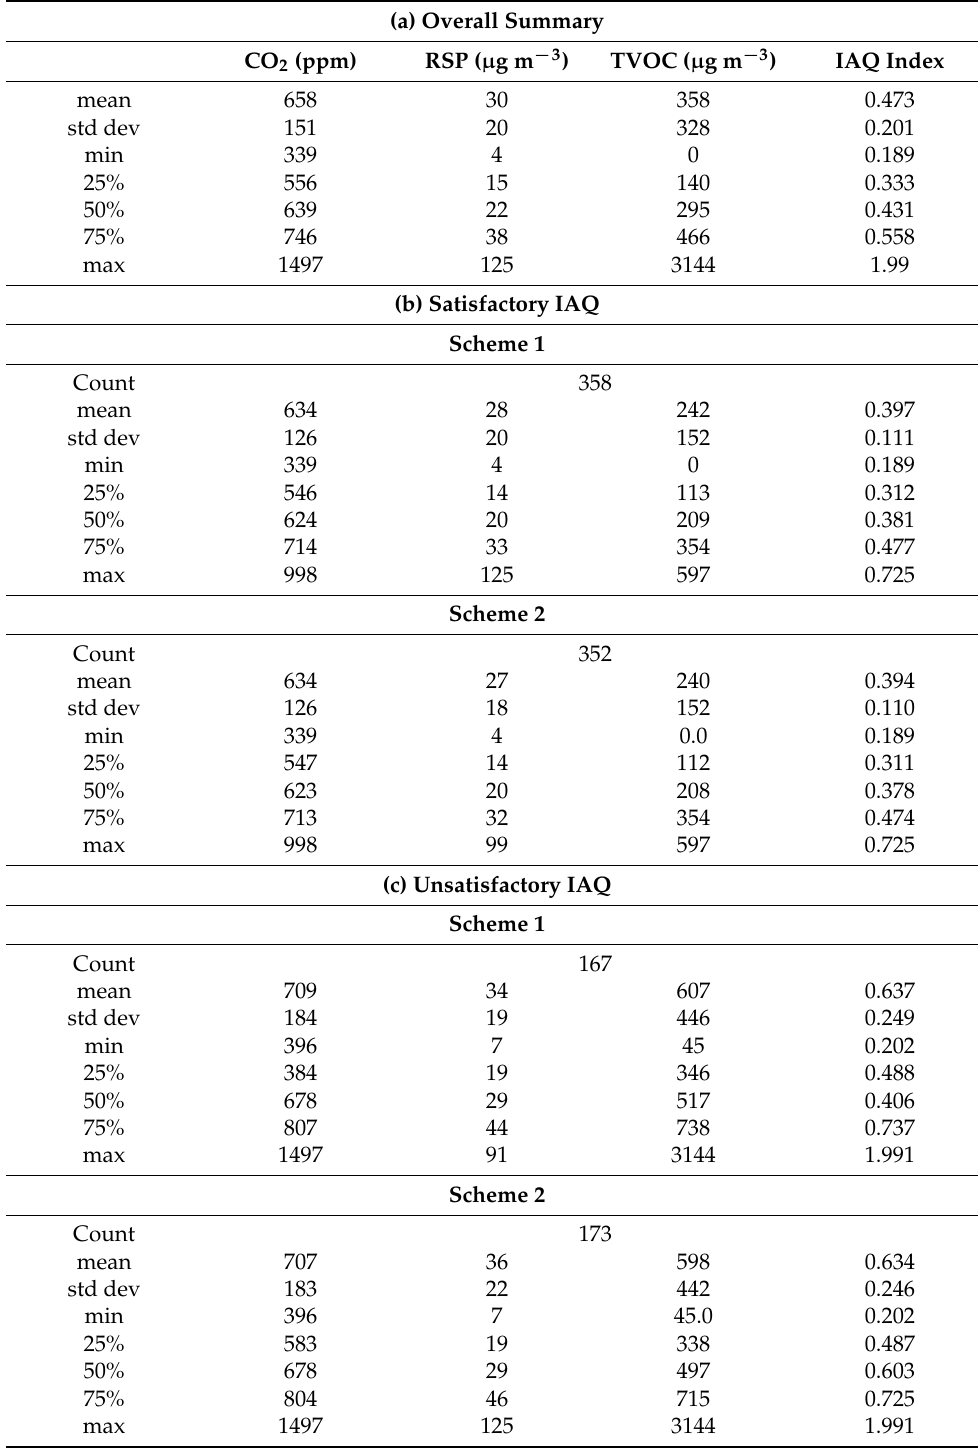
Table 2. Statistical summary of levels of indoor air quality surrogate parameters in 525 offices, ( a ) overall summary; ( b ) summary of the dataset being classified as “Satisfactory IAQ” regarding Schemes 1 and 2; ( c ) summary of the dataset being classified as “Unsatisfactory IAQ” regarding Schemes 1 and